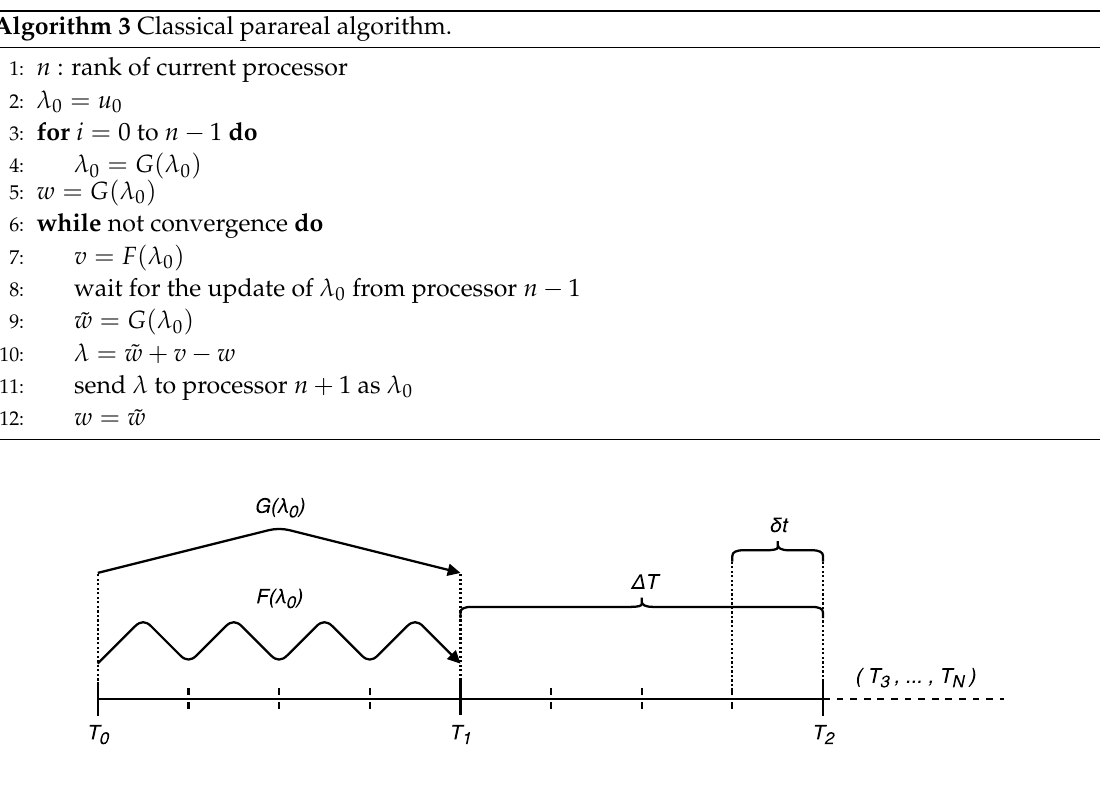
Figure 4. Parareal iterative scheme. F propagates step-by-step, whereas G performs only one step in each subdomain. We compute λ n + 1 by combining the predictor and the corrector, then, proceed with the next